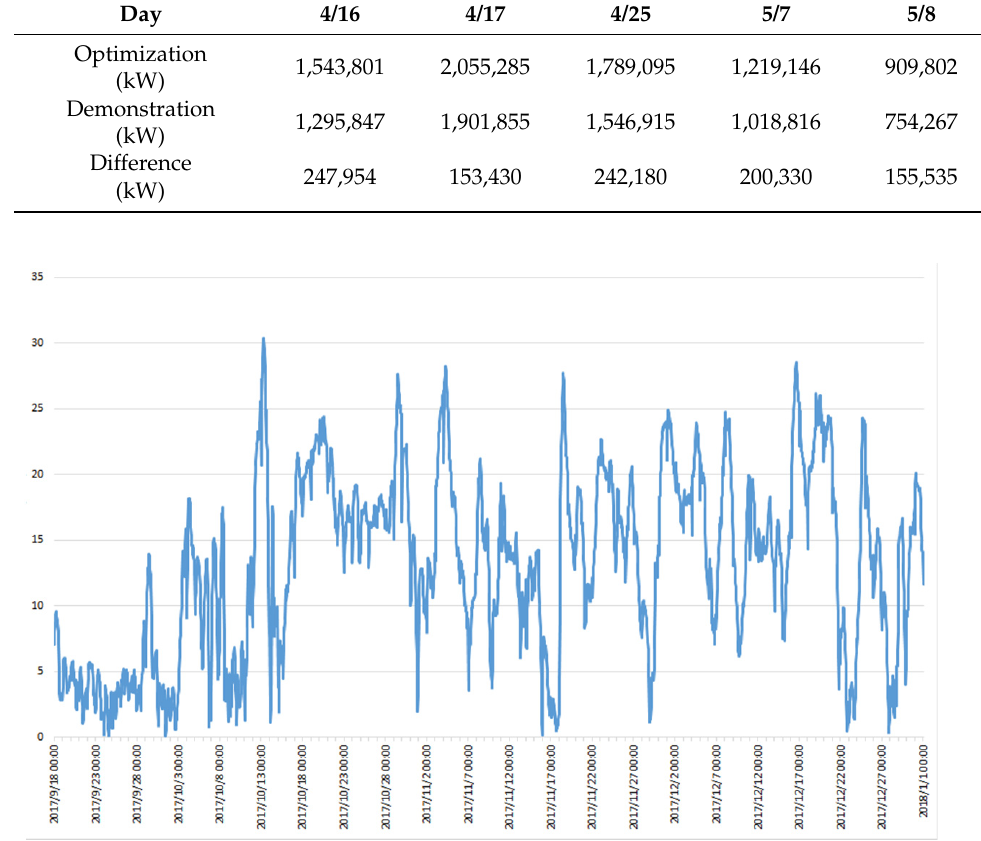
Figure 17. Power chart between 18 September and 1 Januaryin 2018. The orange line is the best power by DGA, and the blue line is the default power.